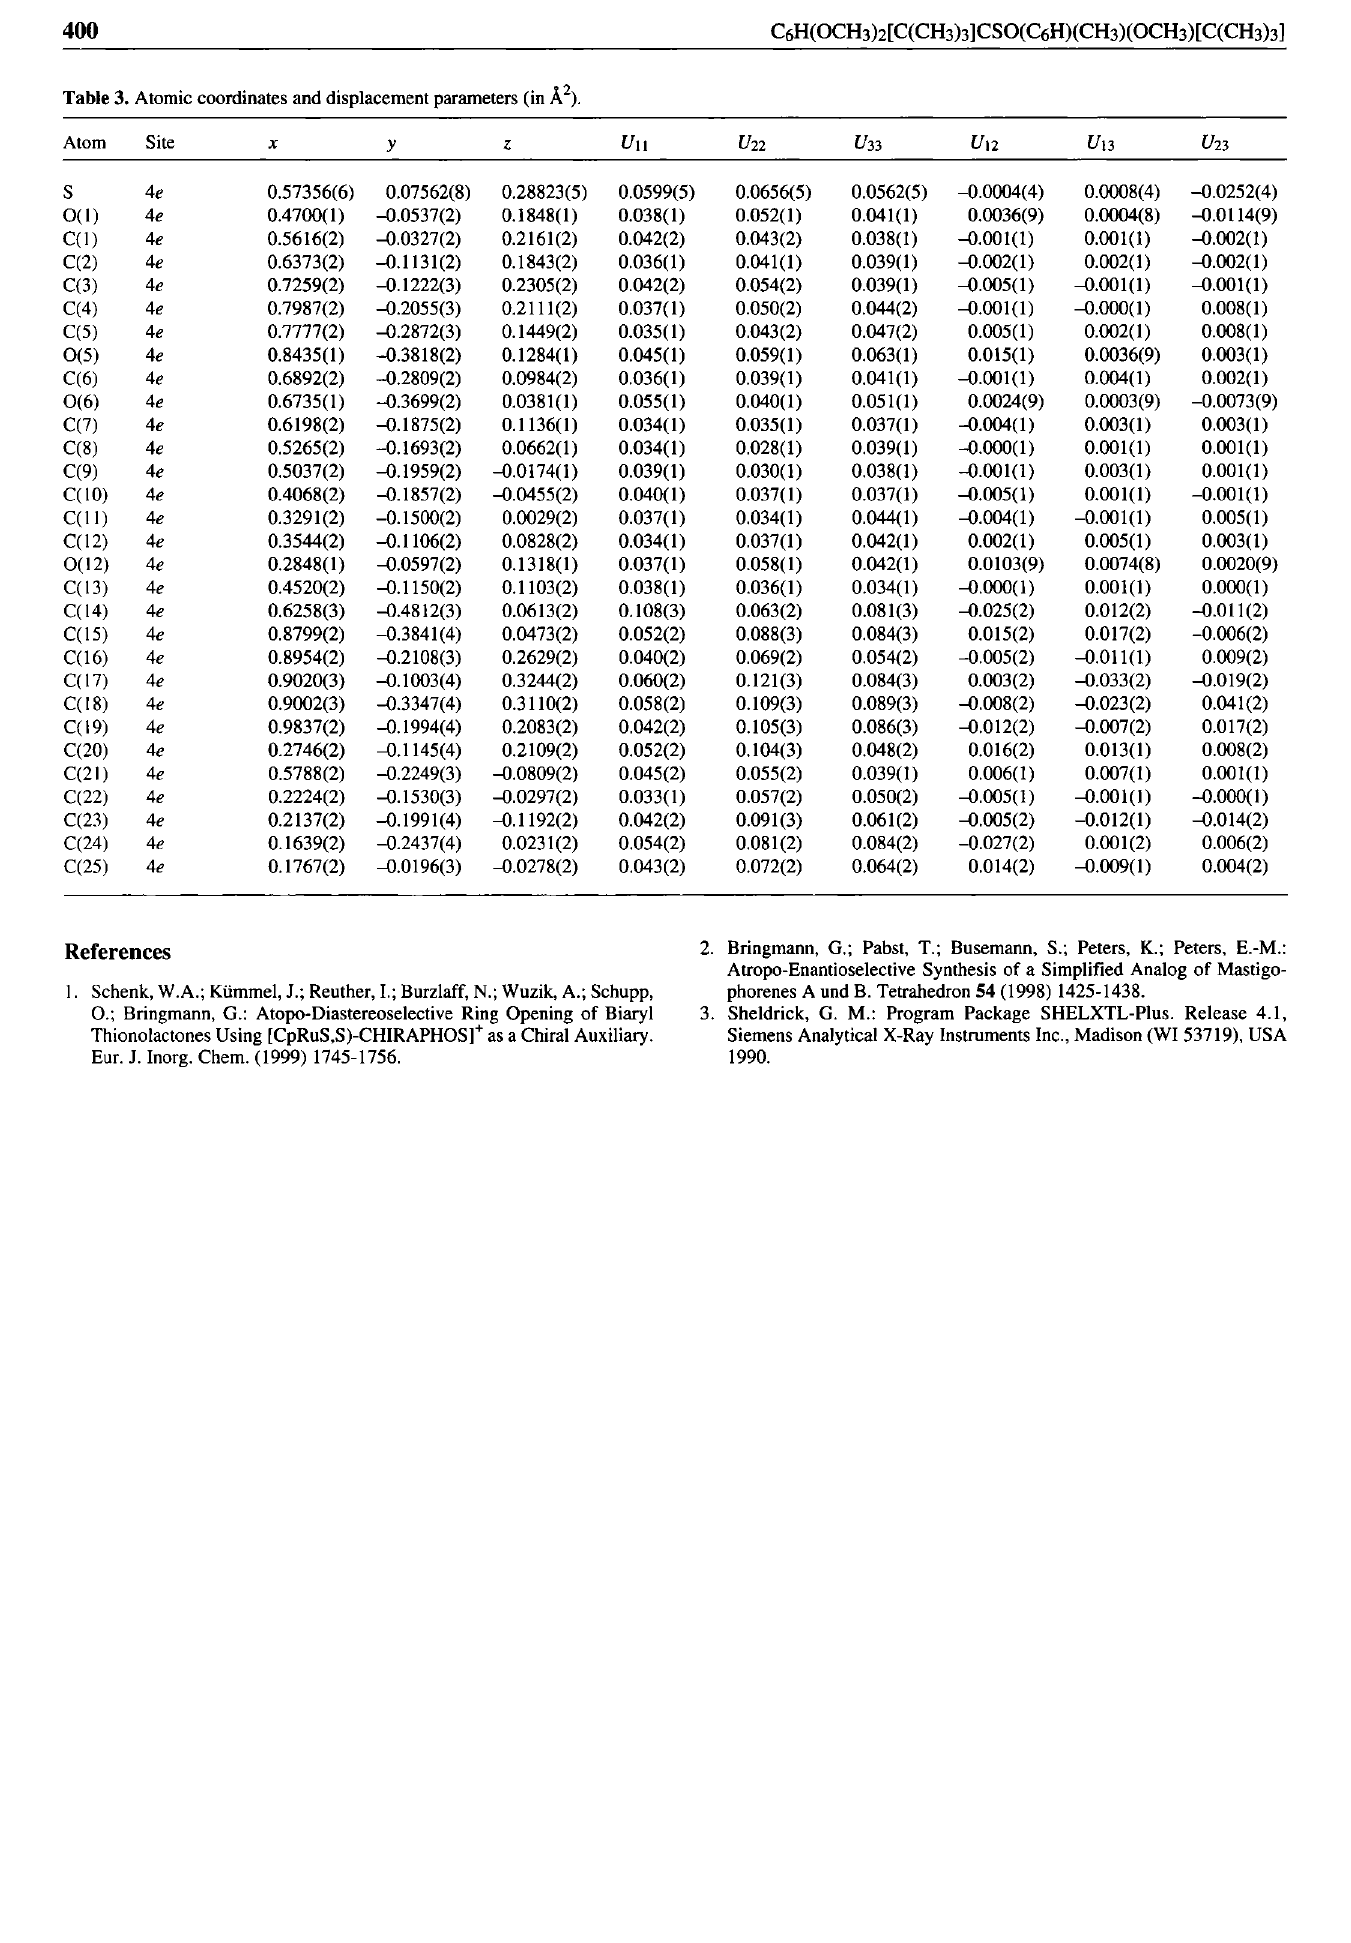
Table 3. Atomic coordinates and displacement parameters (in A 2 ).